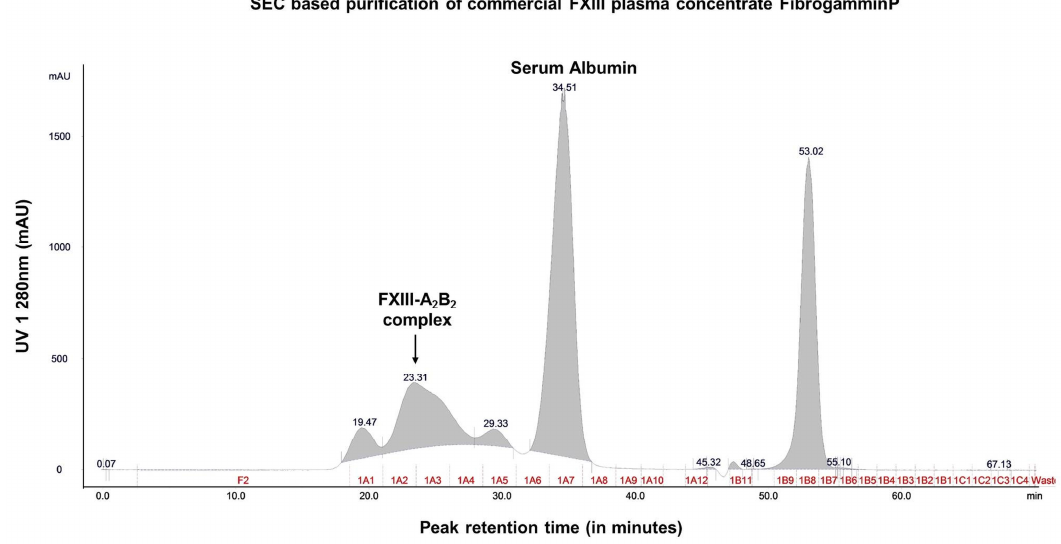
Figure 1. Content characterization of plasma FXIII concentrate (FibrogamminP) by size exclusion chromatography. This image represents the mass-based separation run for commercial plasma FXIII concentrate FibrogamminP on a ÄKTA explorer purifier system. The respective peaks on the chromatograph were detected by UV_280. The arrow indicates the main peak corresponding to the molecular weight of FXIII-A 2 B 2 complex that was further characterized.